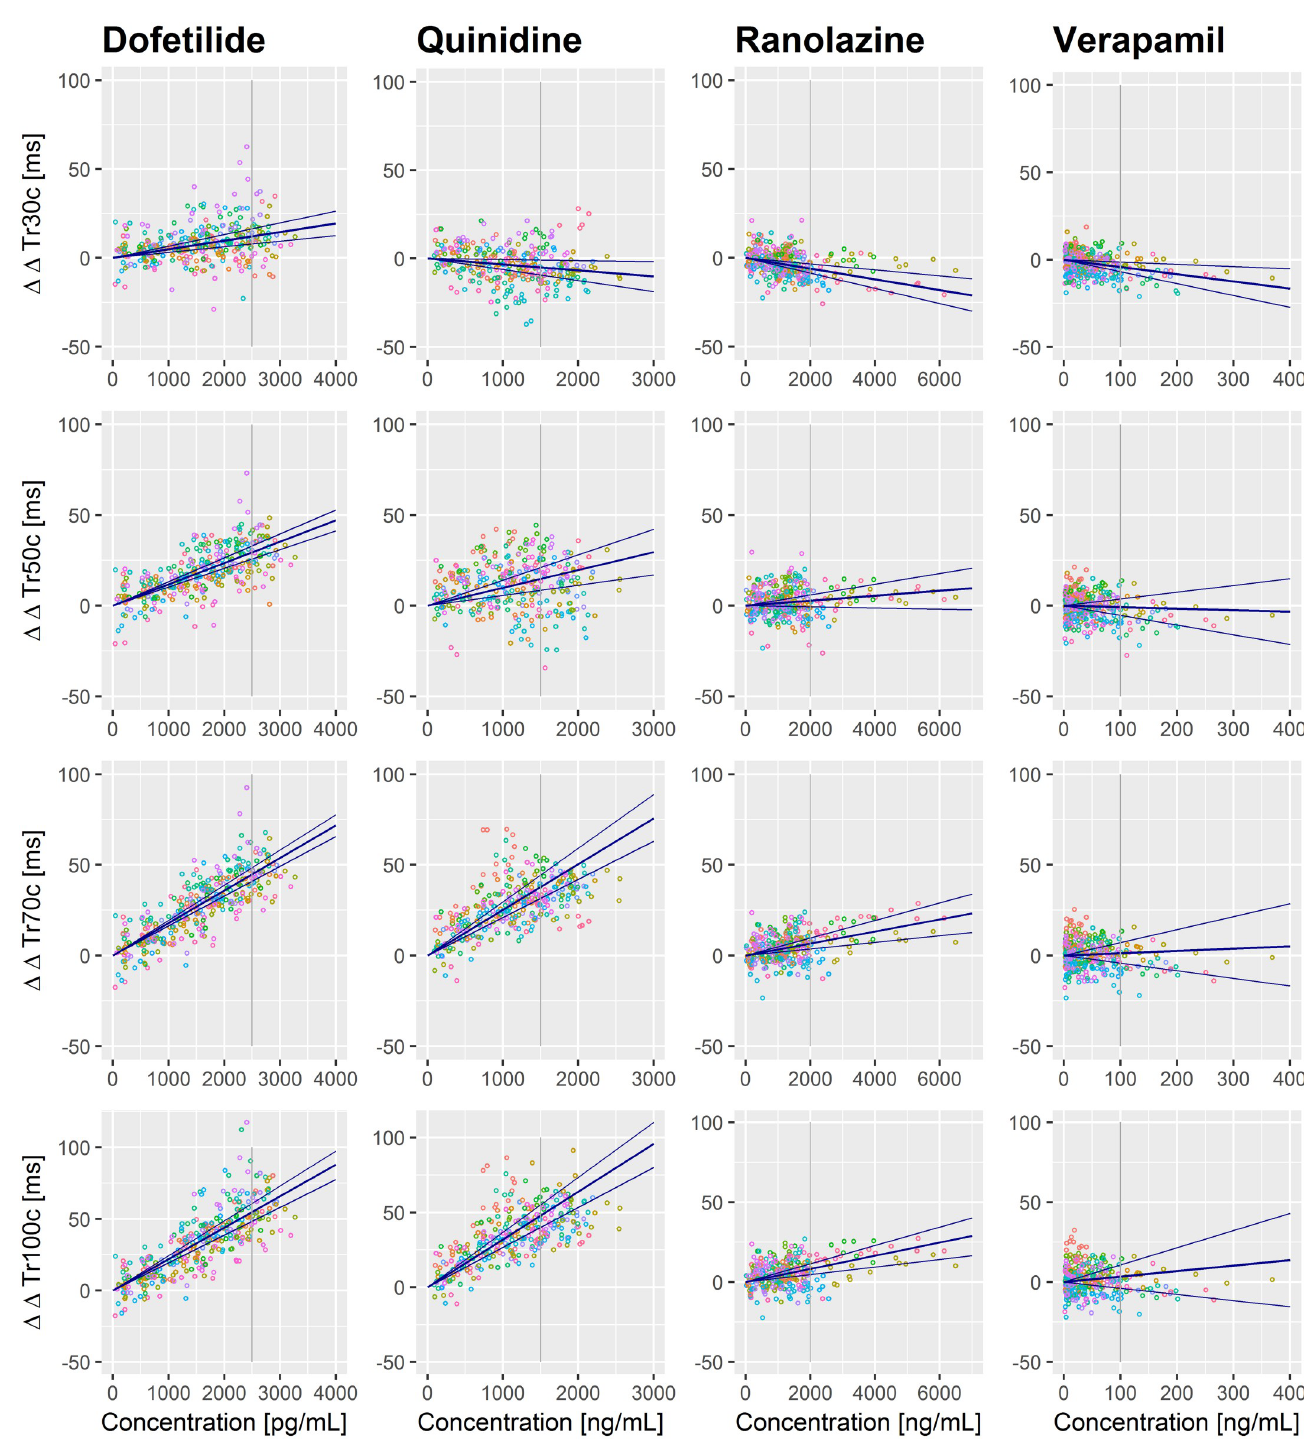
Fig 3. Exposure response in Study A. Effects of dofetilide, quinidine, ranolazine, and verapamil determined as exposure-response relation of the plasma drug concentrations on the double-delta parameters Tr30c, Tr50c, Tr70c, and Tr100c. The blue lines indicate the estimated slope with its 95% confidence interval. The colors of the data points denote individual subjects. The grey vertical lines denote the drug concentrations used for calculating the drug effect profiles in Fig 4.